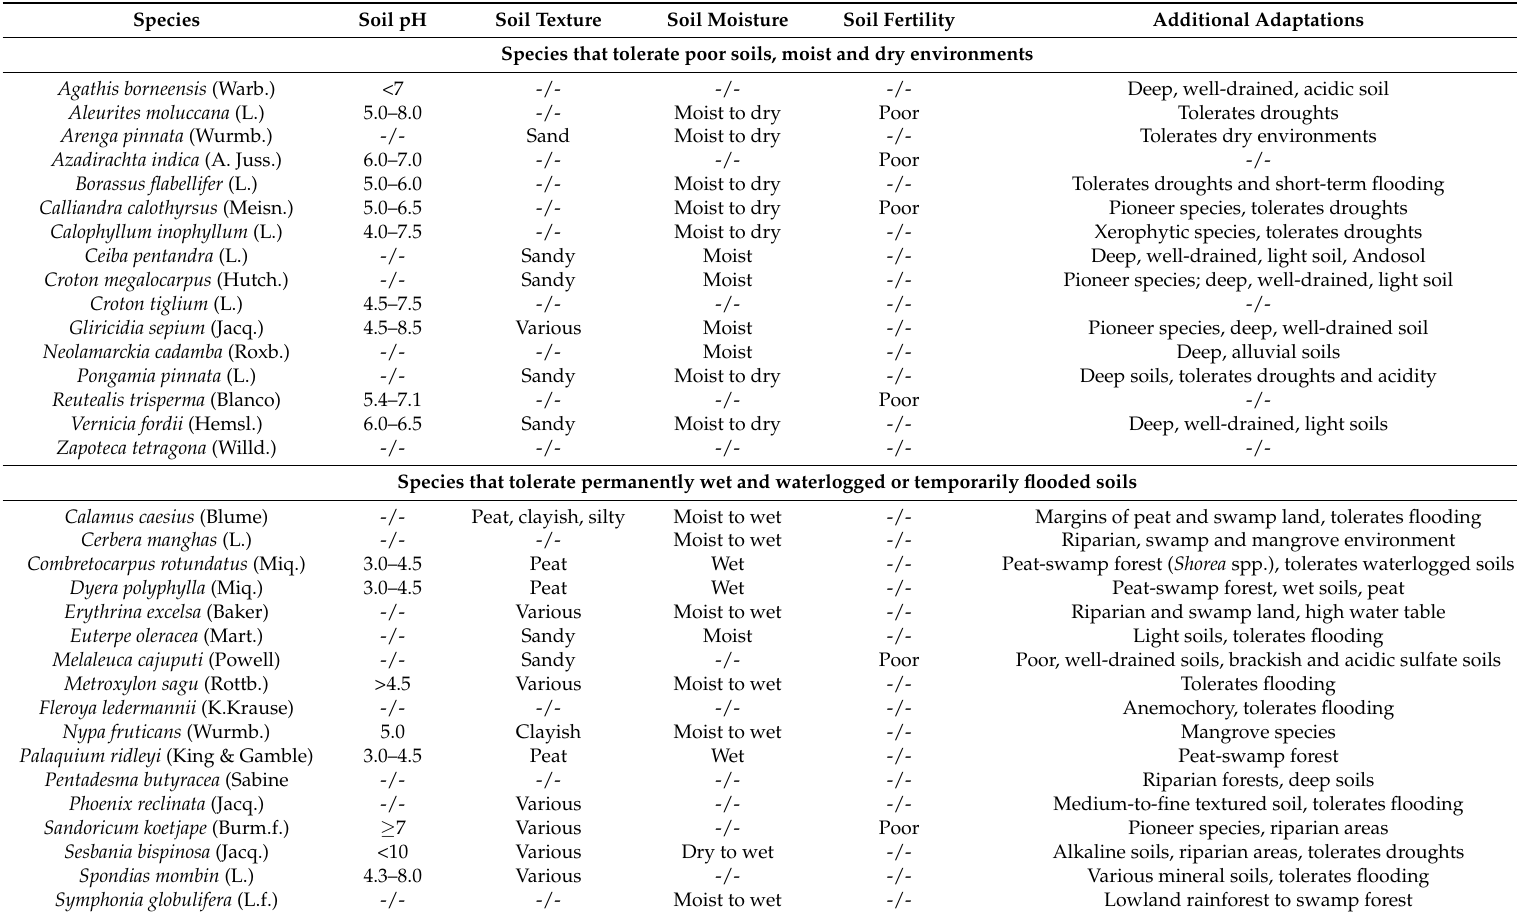
Table 1. Potential bioenergy species that tolerate unfavorable soil conditions. Soil conditions that are most relevant for species selection are presented. Potential ecological adaptations are also shown to inform about tolerances toward to for instance droughts and flooding. Primary data and their corresponding references are shown in Table